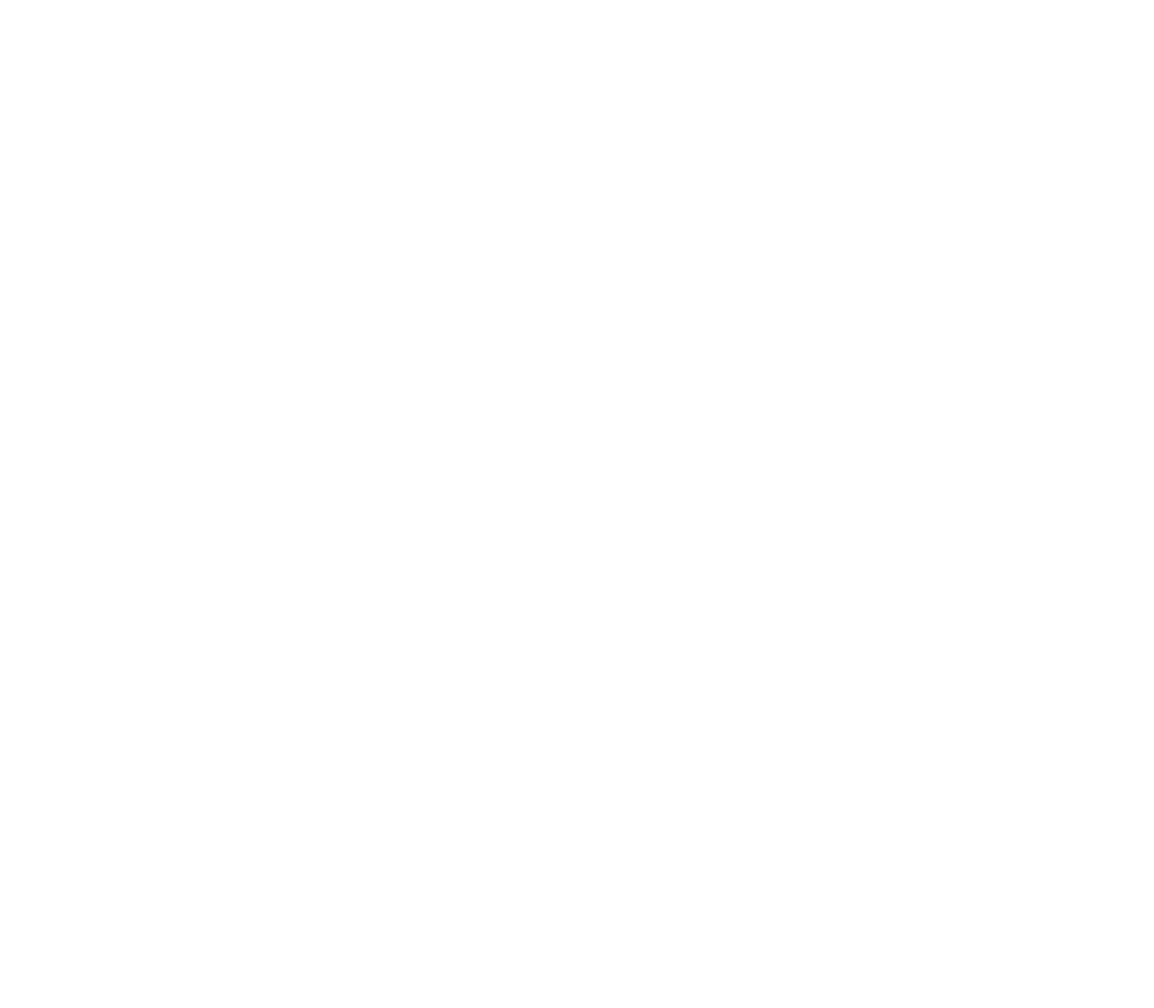
FIGURE A3 | Empirical distribution functions for additivity of GP maps. Summary of V A / V G from unweighted regression for all motifs for which at least 100 (out of 1000) Monte Carlo simulations lead to GP maps with non-negligible phenotypic variation (see Models and Methods section “Gene regulatory network simulations,” for detailed criteria). Results are shown for 1013 motifs with a genotype-to-parameter map without pleiotropy (A)